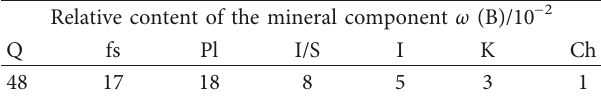
Figure 2: Picture of the developed freeze-thaw